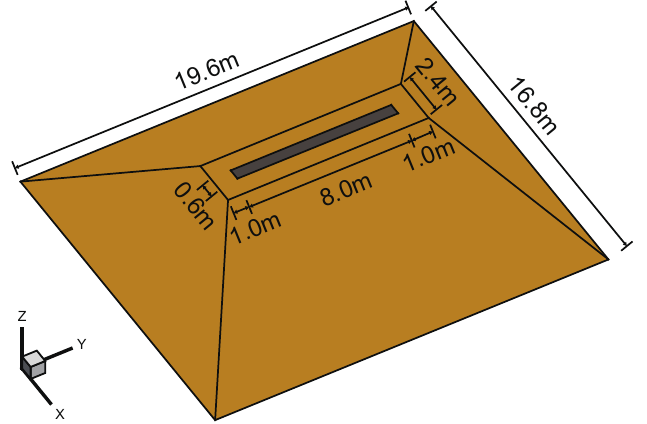
Figure 10. The size of Example 3 model.